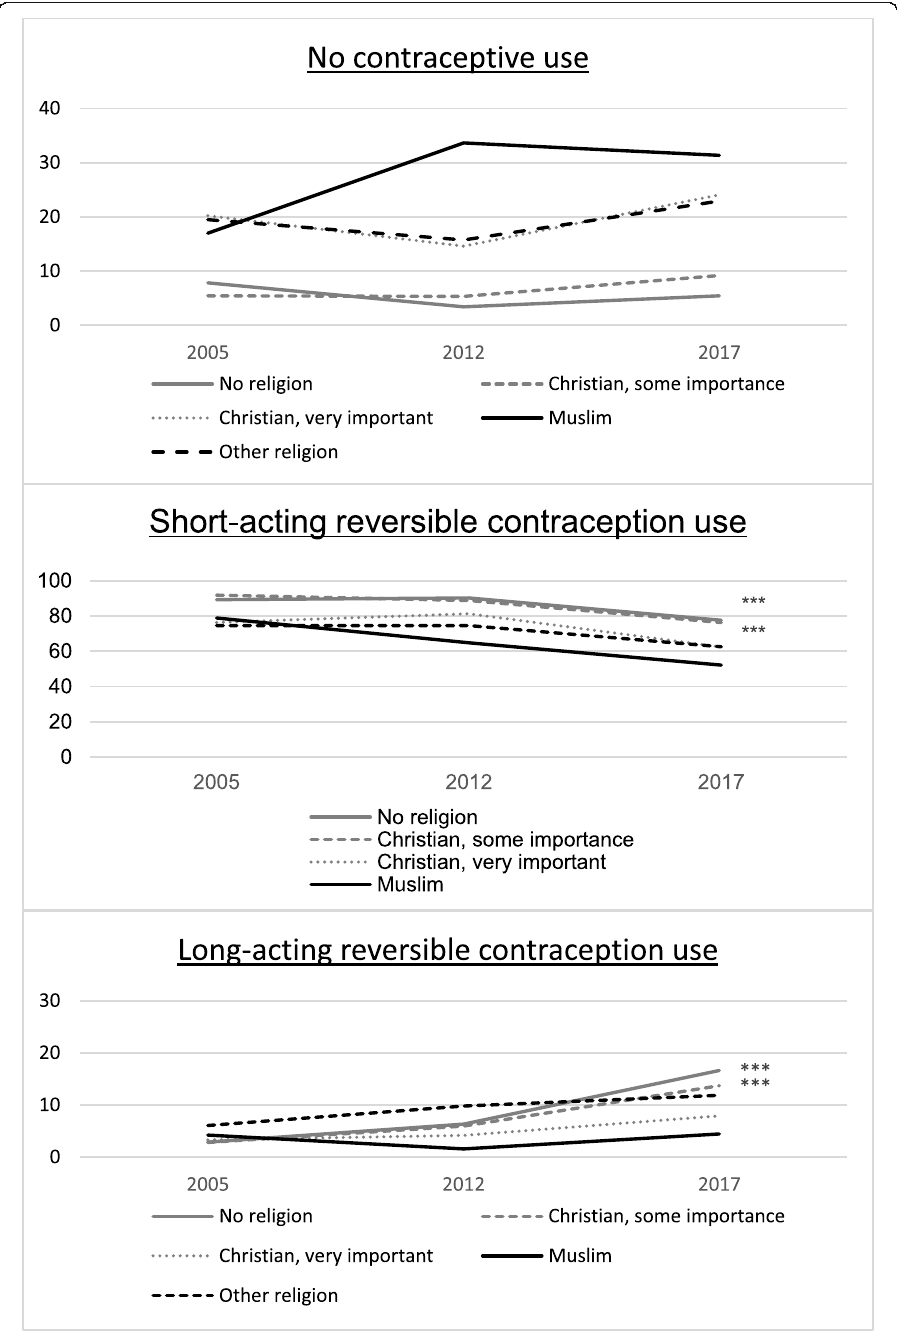
Fig. 3 trends over time in contraceptive use by religion. Trends differed significantly by religion group (p=.024). # Numbers in some groups are small, explaining the large proportional differences tha show no statistically significant trend. Significance indicated; ** p <0.01, *** p